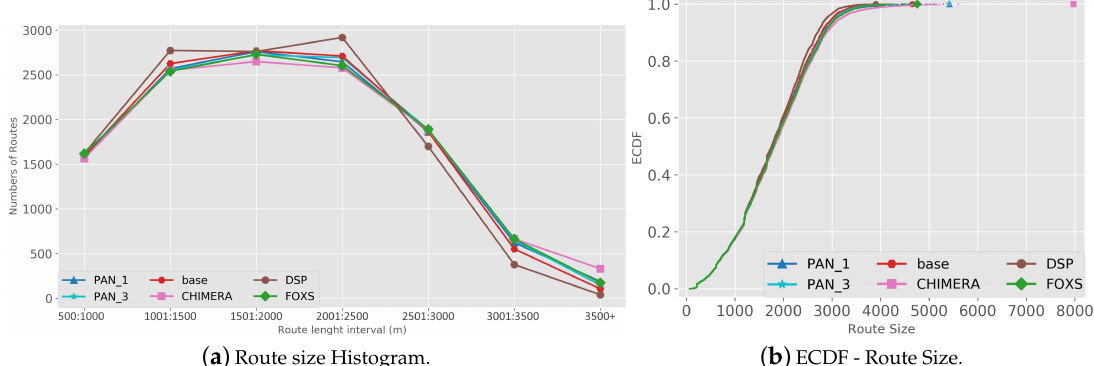
Figure 19. Route Size Analise—Cologne